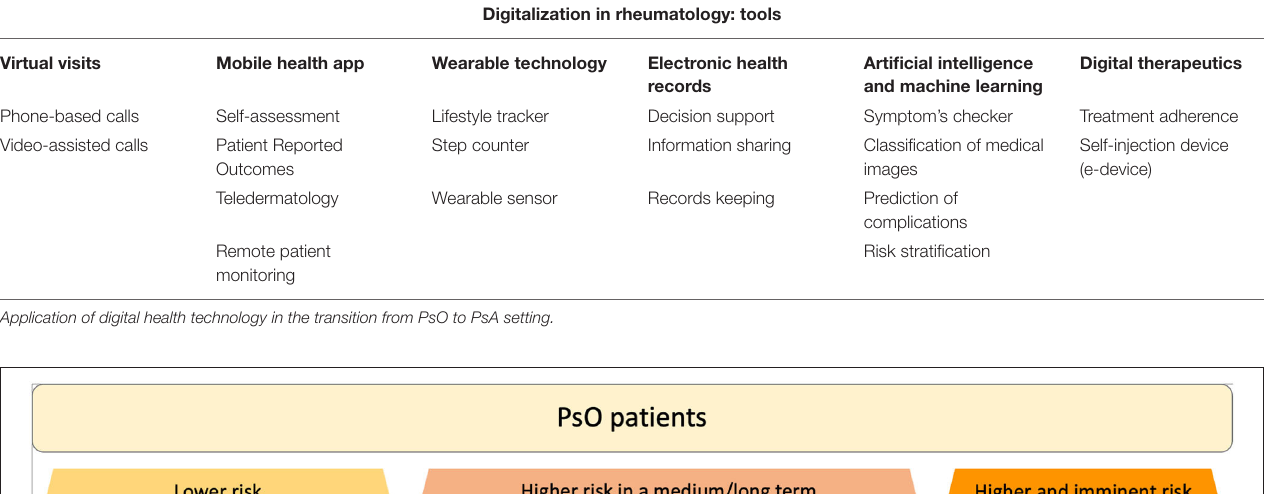
TABLE 1 | Digitalization in rheumatology.